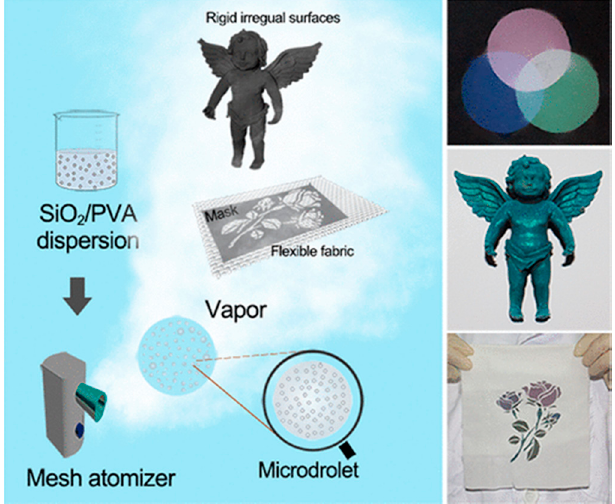
Figure 3. Schematic illustration showing the fabrication process of amorphous SiO 2 nanoparticles into photonic crystals with noniridescent colors on various substrate materials by atomization deposition. Reprinted with permission from [47] American Chemical Society, 2018.